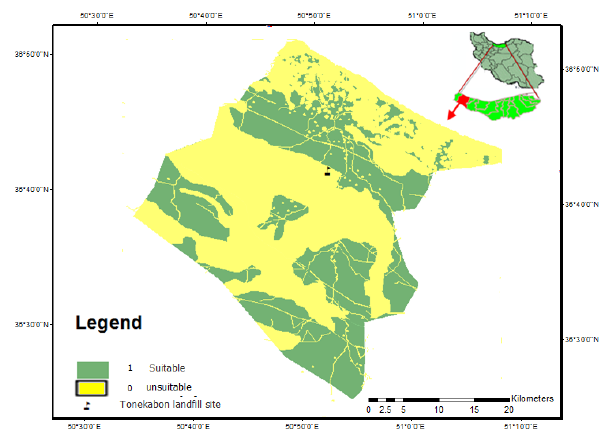
Figure 7. The suitability of the studied area based on regional screening